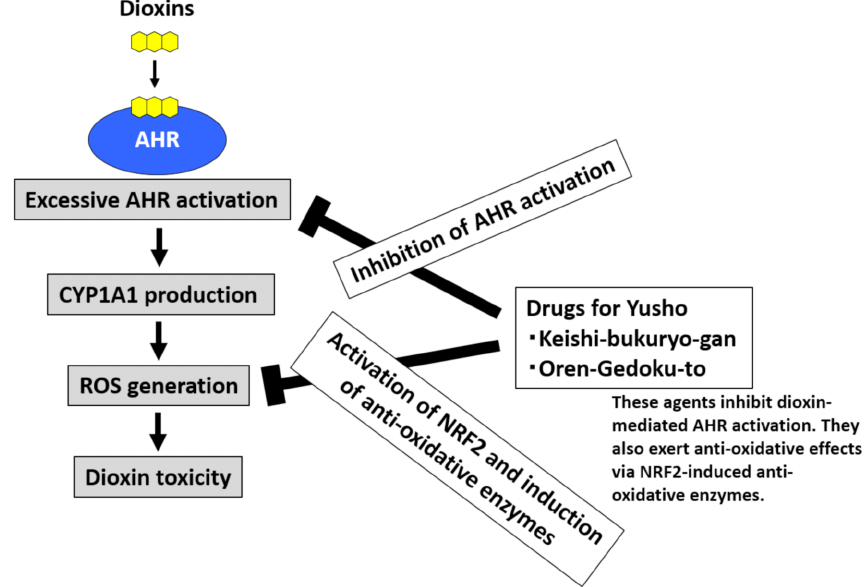
Figure 5. Development of drugs for Yusho. Dioxins activate aryl hydrocarbon receptor (AHR) and induce cytochrome P450 1A1 (CYP1A1) production. CYP1A1 enhances the production of reactive oxygen species (ROS), which are responsible for the toxic effects of dioxins. Kampo herbal medicines contain many phytochemicals that can inhibit AHR activation and stimulate the antioxidative system via nuclear factor-erythroid 2-related factor-2 (NRF2) activation. The commercially available Kampo formulae Keishi-bukuryo-gan and Oren-gedoku-to both inhibit AHR and stimulate NRF2 activity. These remedies are potentially useful for the treatment of Yusho and other health hazards associated with dioxin